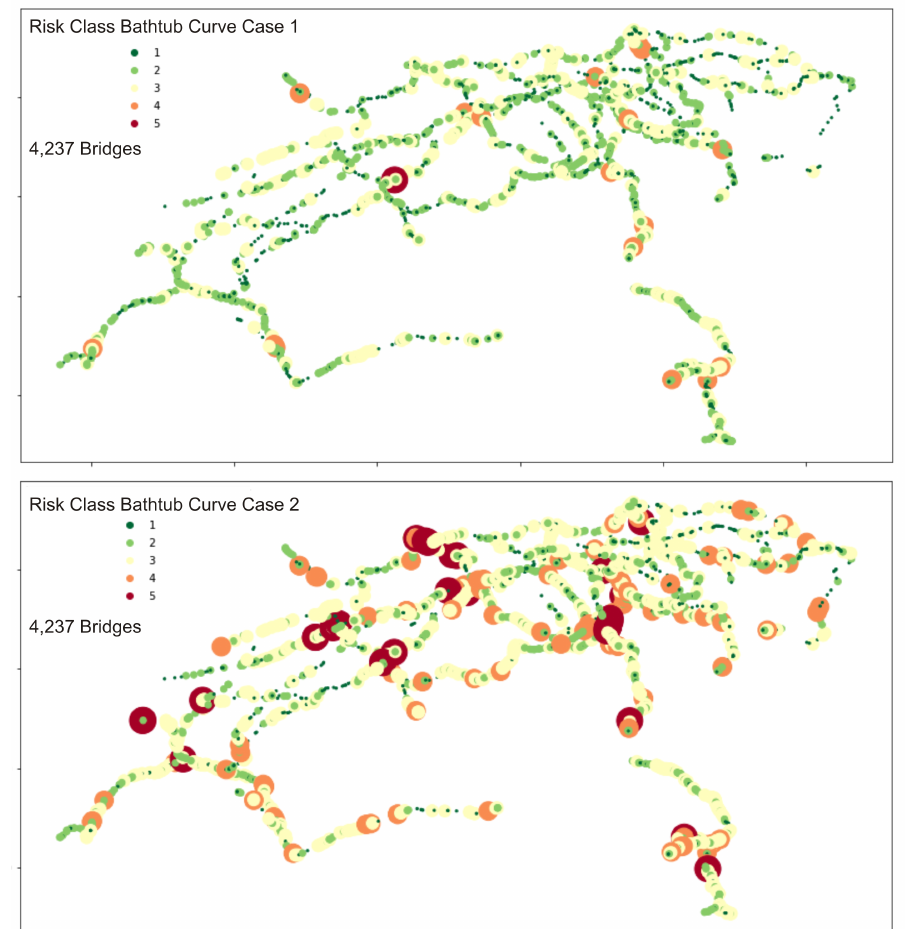
Figure 7. Geographical location of the SBB bridges and representation of the respective risk class for two